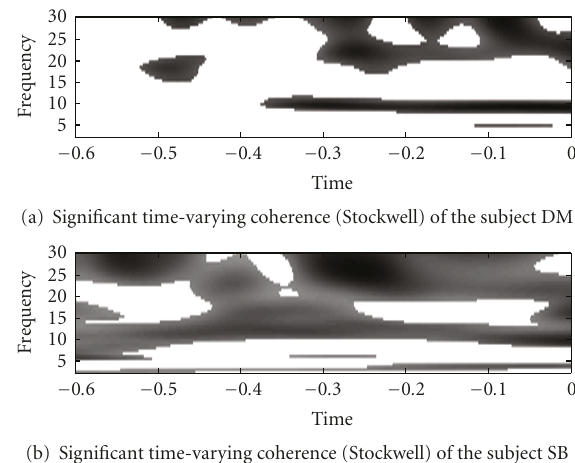
Figure 5: The significant time-varying coherence based on the ST- spectrogram for the subjects DM and